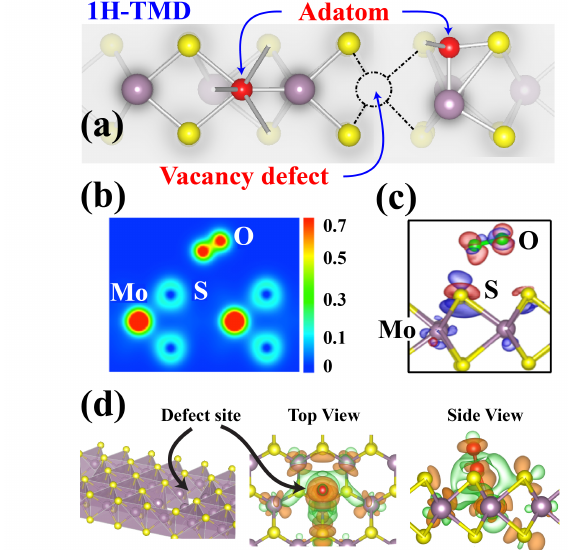
Figure 2: (a) Defect sites in monolayer TMDs, shown for an adsorbed adatom and a vacancy. Purple, yellow, and red spheres are the tran- sition metal, chalcogen, and adatom, respectively. (b) Charge den- sity distribution of an O 2 molecule physisorbed on the surface of MoS 2 . The color scale is in units of e/Å 3 (c) Charge density differ- ence between pristine MoS 2 and MoS 2 with O 2 physisorbed on its surface. Red indicates charge accumulation and blue charge deple- tion. (d) Monolayer MoS 2 with a S 2 vacancy, together with top and side views of charge density difference plots of monolayer MoS 2 with a S 2 vacancy interacting with a N 2 molecule (red). Orange de- notes charge accumulation and green charge